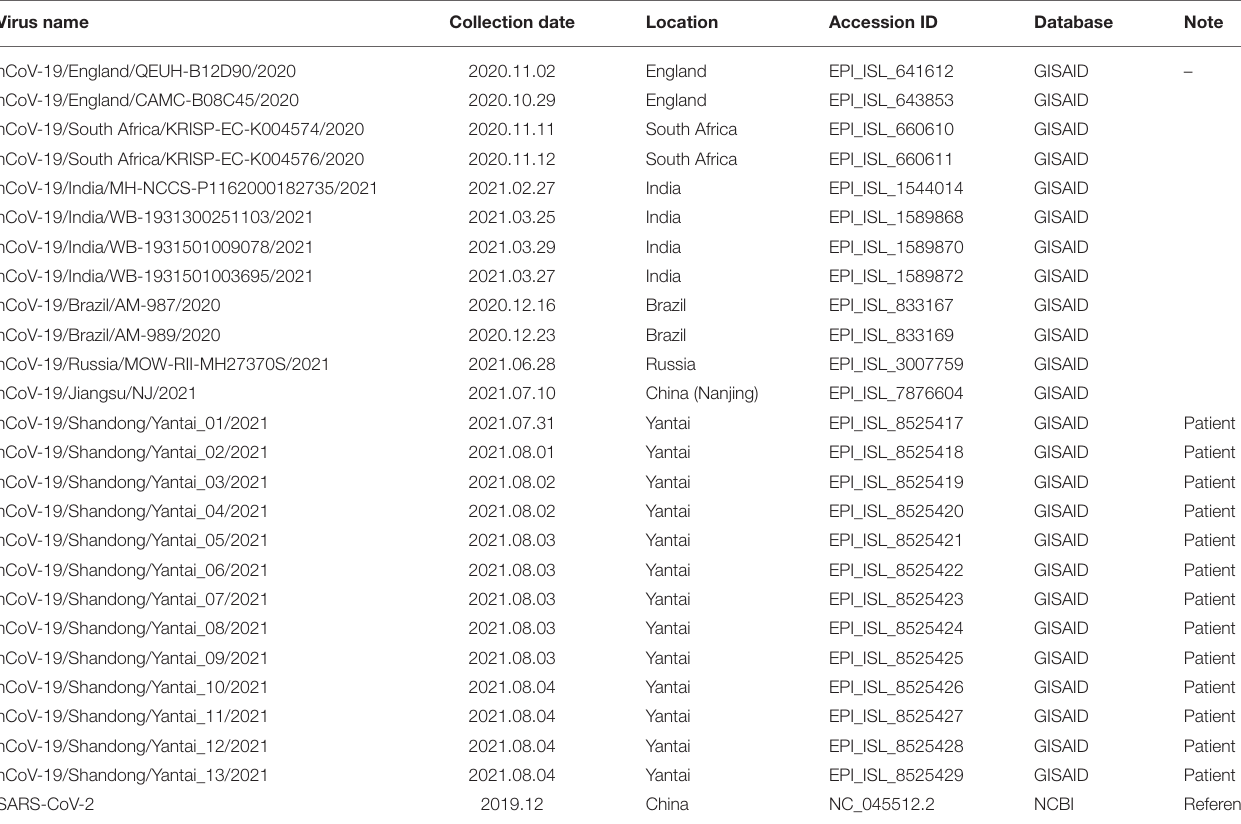
TABLE 2 | Details of all sequences involved in this